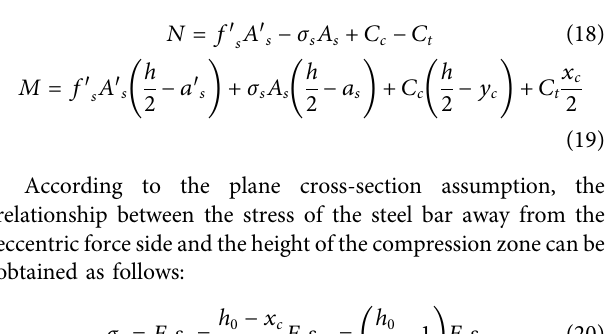
Frontiers in Materials |